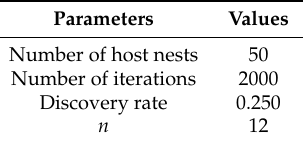
Table 4. Cuckoo Search Optimization Algorithm (CSOA)